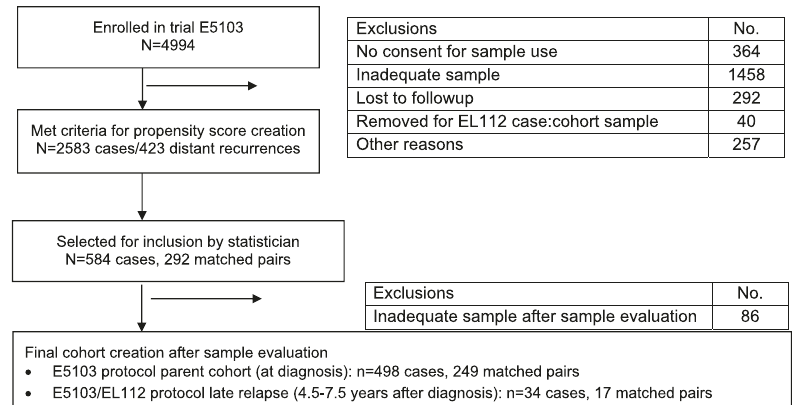
Fig. 1 CONSORT diagram. Diagram indicating patients included and excluded from analysis and reasons for exclusion.